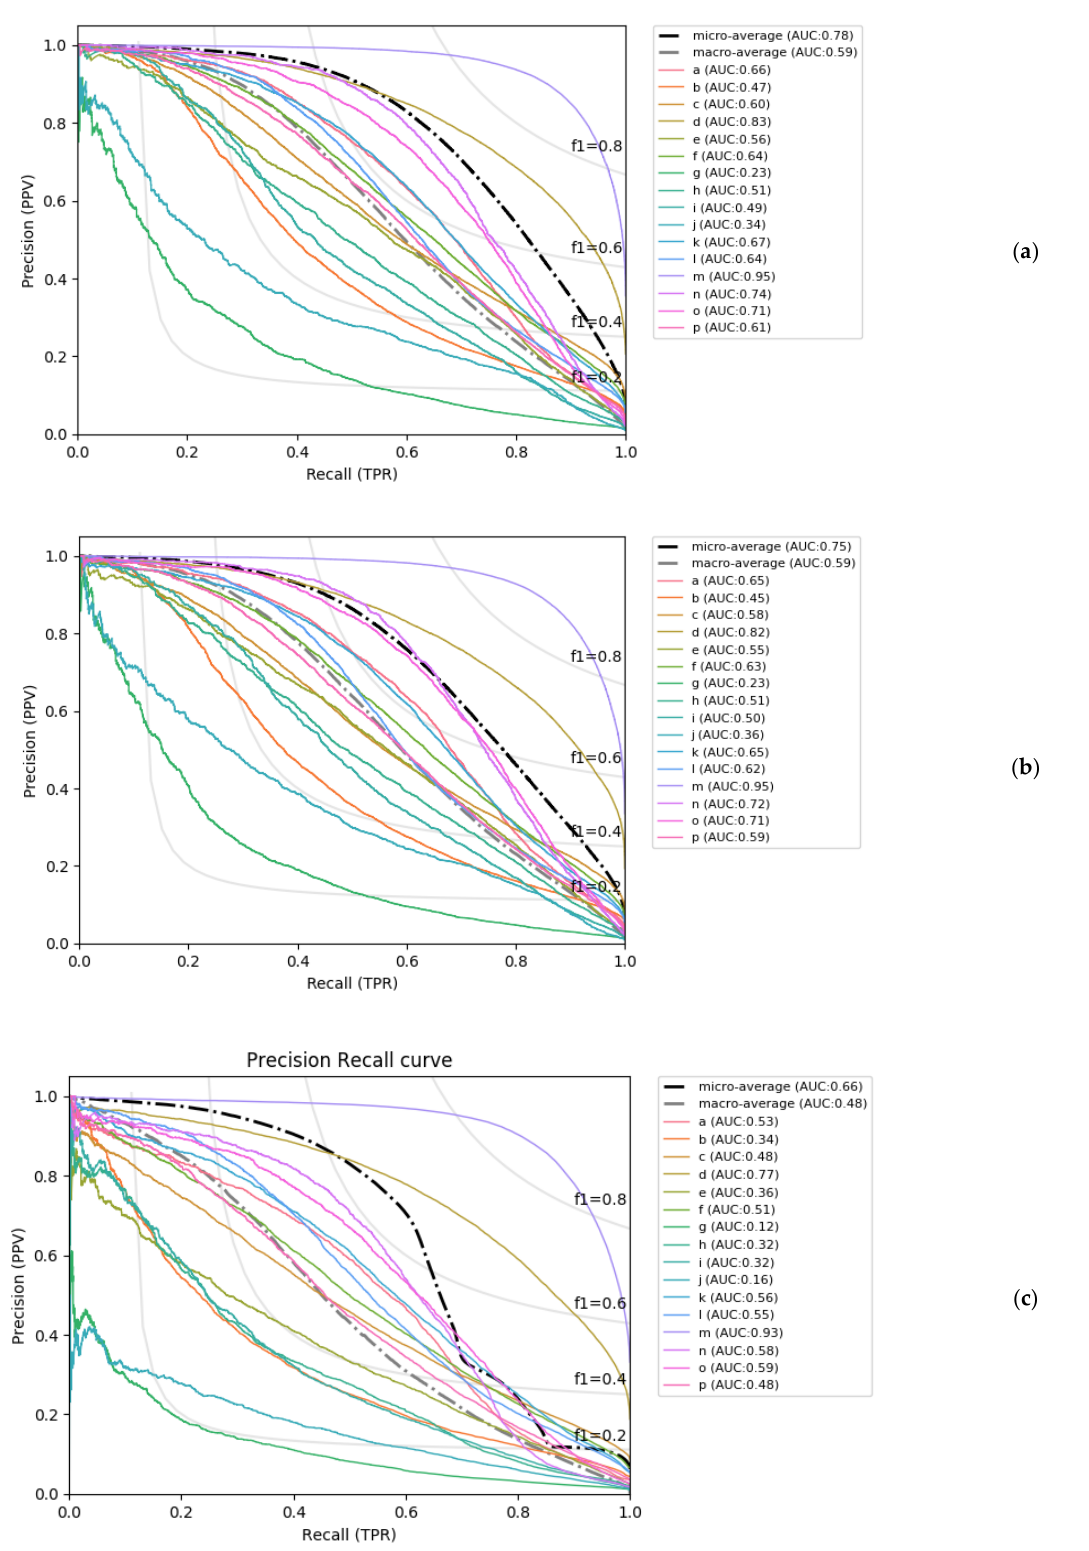
Figure 3. Precision-recall curves (PRC) of PYTHIA on the test dataset for ( a ) the best global accuracy model and ( b ) the best balanced accuracy model, and ( c ) the PRC curve of LOCUSTRA on the same test